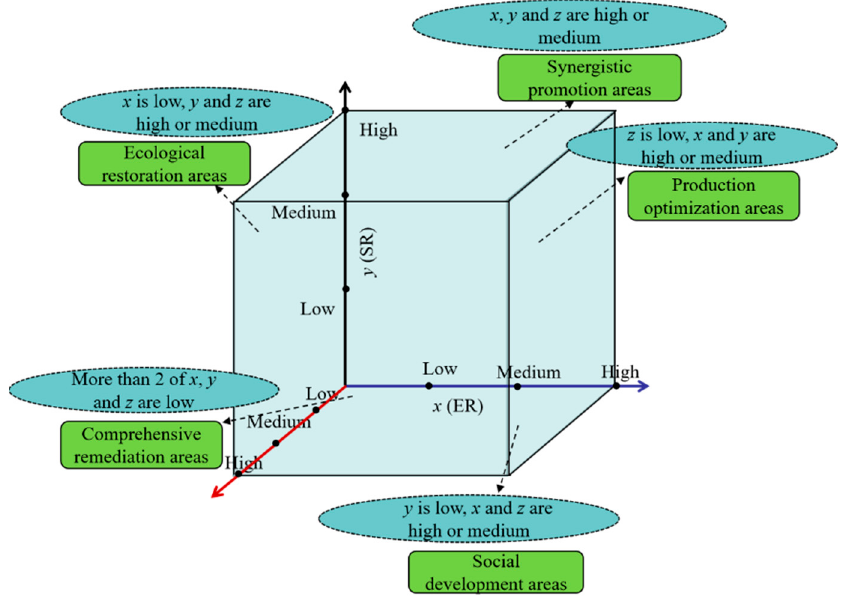
Figure 2. Magic cube of the connotation property of social–ecological production landscape resilience (SEPLR) and partition conceptual model.